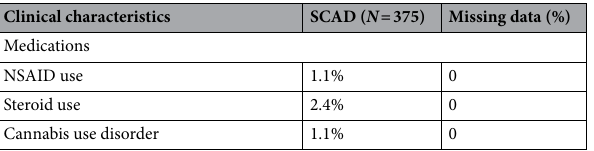
Table 1. Selected baseline clinical characteristics of patients with SCAD. NSAIDs nonsteroidal anti- inflammatory drugs.